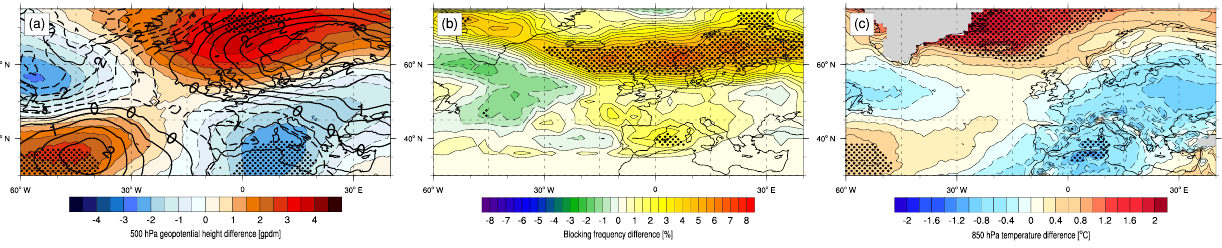
Figure 4. 1958–2009 low minus high solar activity differences computed with ERA-40/Interim. (a) 500hPa geopotential height (colour) in gpdm and sea level pressure (contour) in hPa. (b) Blocking frequency in %. (c) 850hPa temperature in ◦ C. The 95% significance level is indicated with stippled